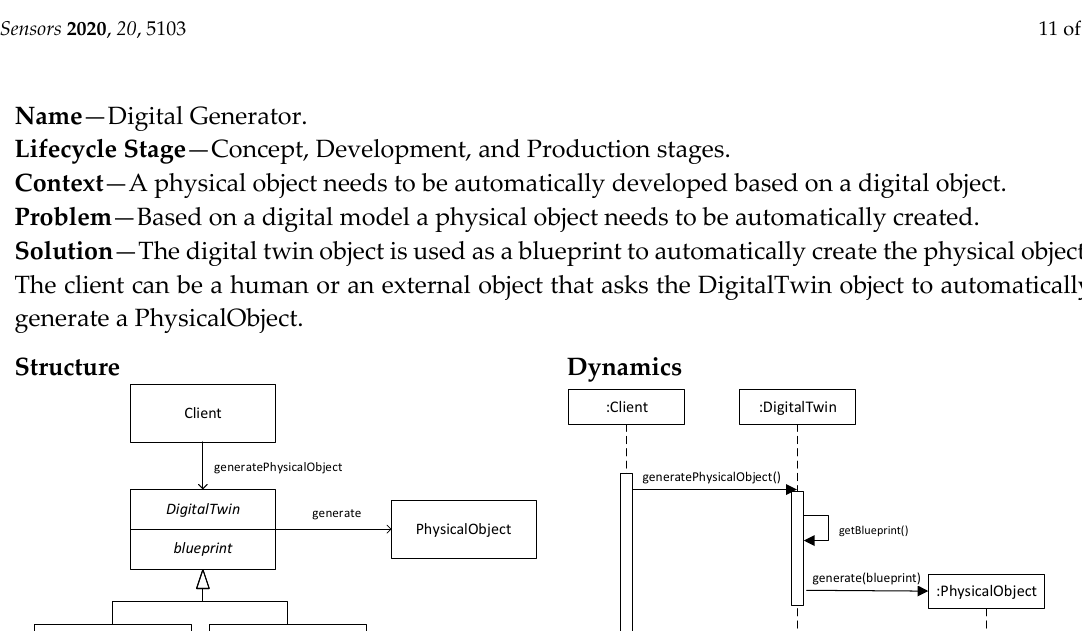
Figure 8. Digital Generator pattern.